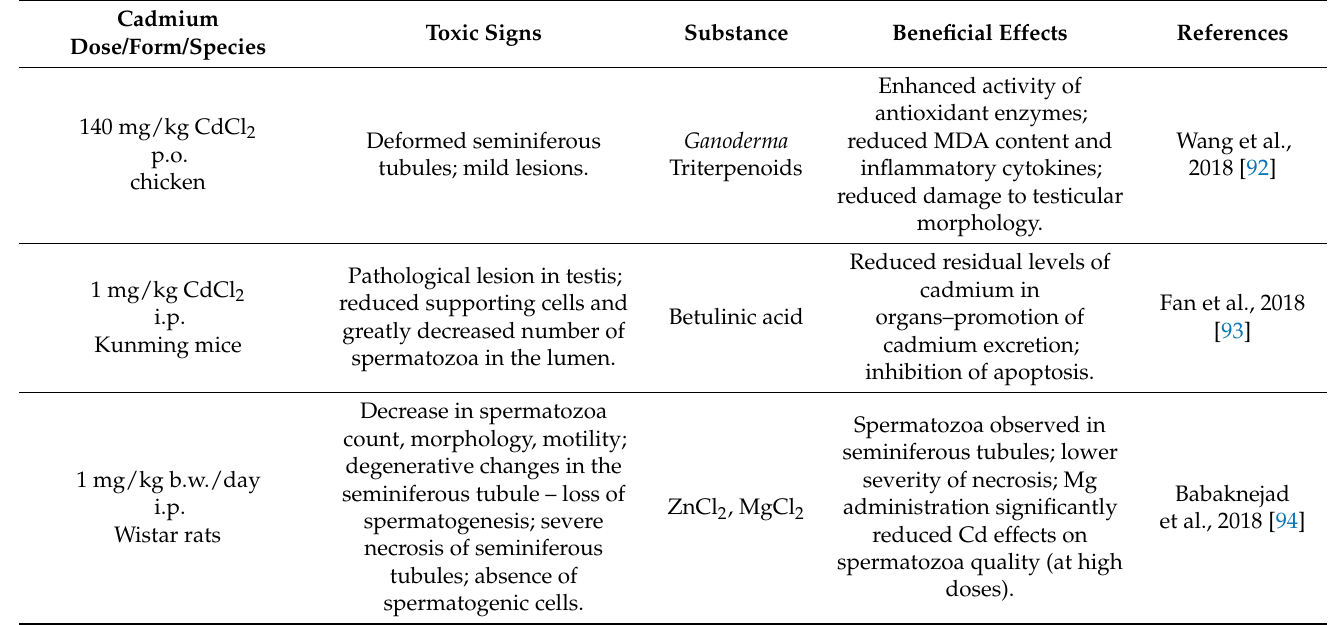
Table 5. Experimental ameliorating testicular cadmium